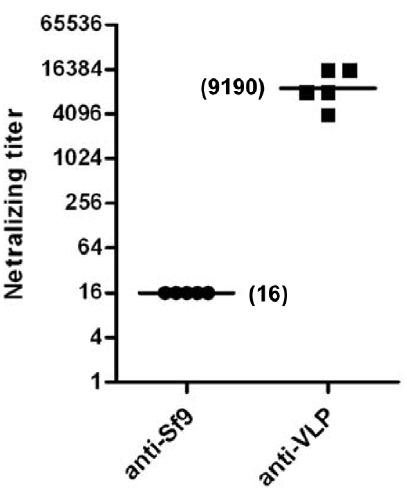
Figure 6. VLP-immunized sera efficiently neutralized EV71 infection invitro . Neutralization titers of the antisera were determined by TCID 50 reduction assay. The antisera of the Sf9 group did not show any neutralization at 1:32 (the lowest dilution tested) and were therefore assigned a titer of 16 for GMT computation. Each symbol represents a mouse, and the line indicates the GMT of the group. Results are representative of two independent experiments.